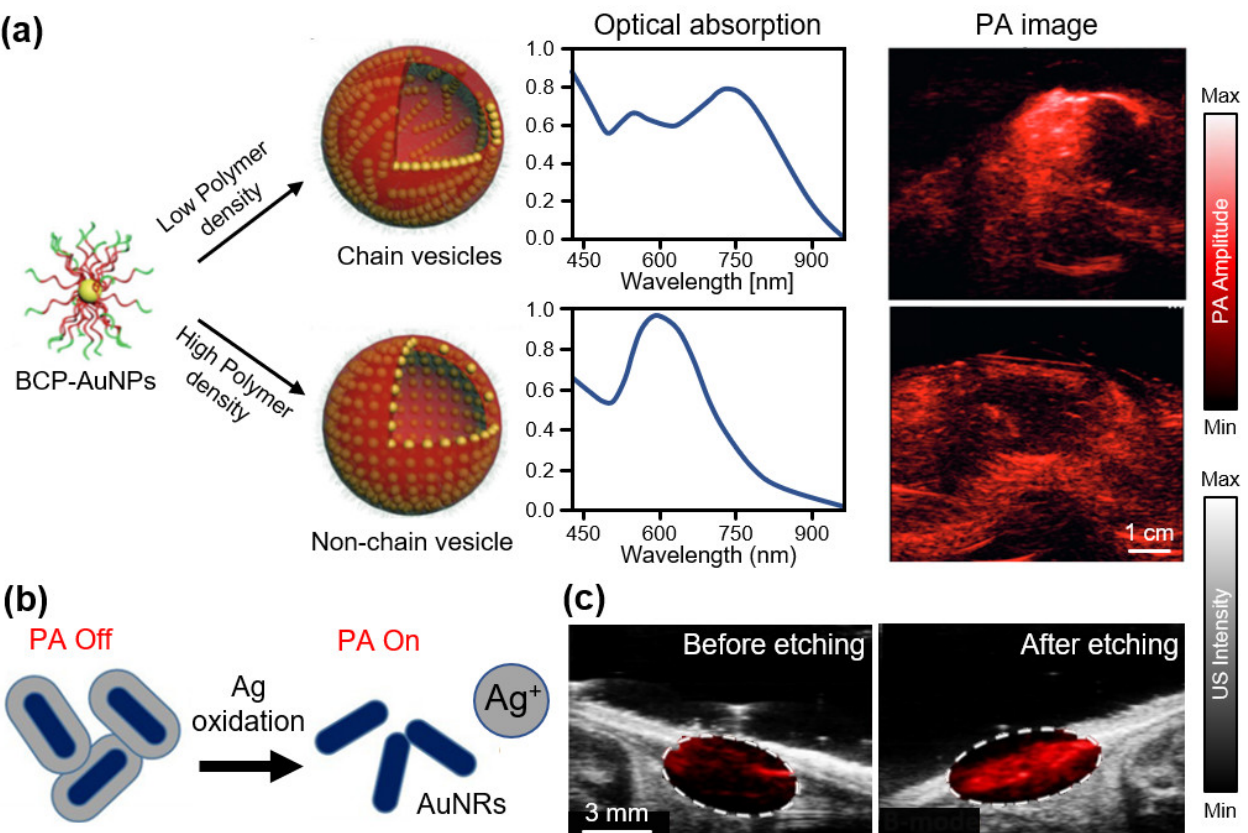
Figure 3. Contrast-enhanced PA imaging of AuNPs. ( a ) Schematic illustration of the synthesis of BCP-AuNP vesicles and their optical absorption spectra and contrast-enhanced PA images. Reprinted with permission from Ref. [90]. 2015, Wiley. ( b ) Schematic illustration of PA switching mechanism with and without Ag layer. ( c ) Overlaid PA and US images before and after Ag etching. PA, photoacoustic; US, ultrasound; BCP, block copolymer; AuNP, gold nanoparticle; AuNR, gold nanorod; Ag, silver. Reprinted with permission from Ref. [91]. 2018, ACS